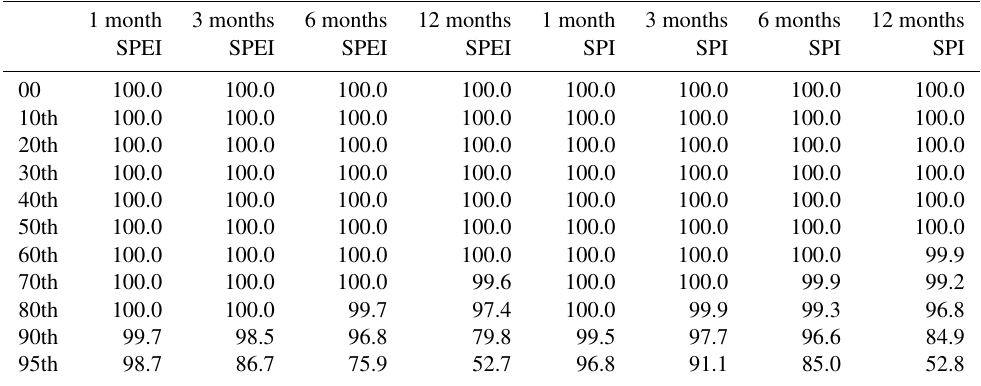
Table 2. Percentage of cases in which the solution for the L moment and the generalized Pareto distribution parameters is found for the peak-over-threshold drought duration–magnitude series at different percentiles from 1-, 3-, 6-, and 12-month SPI and